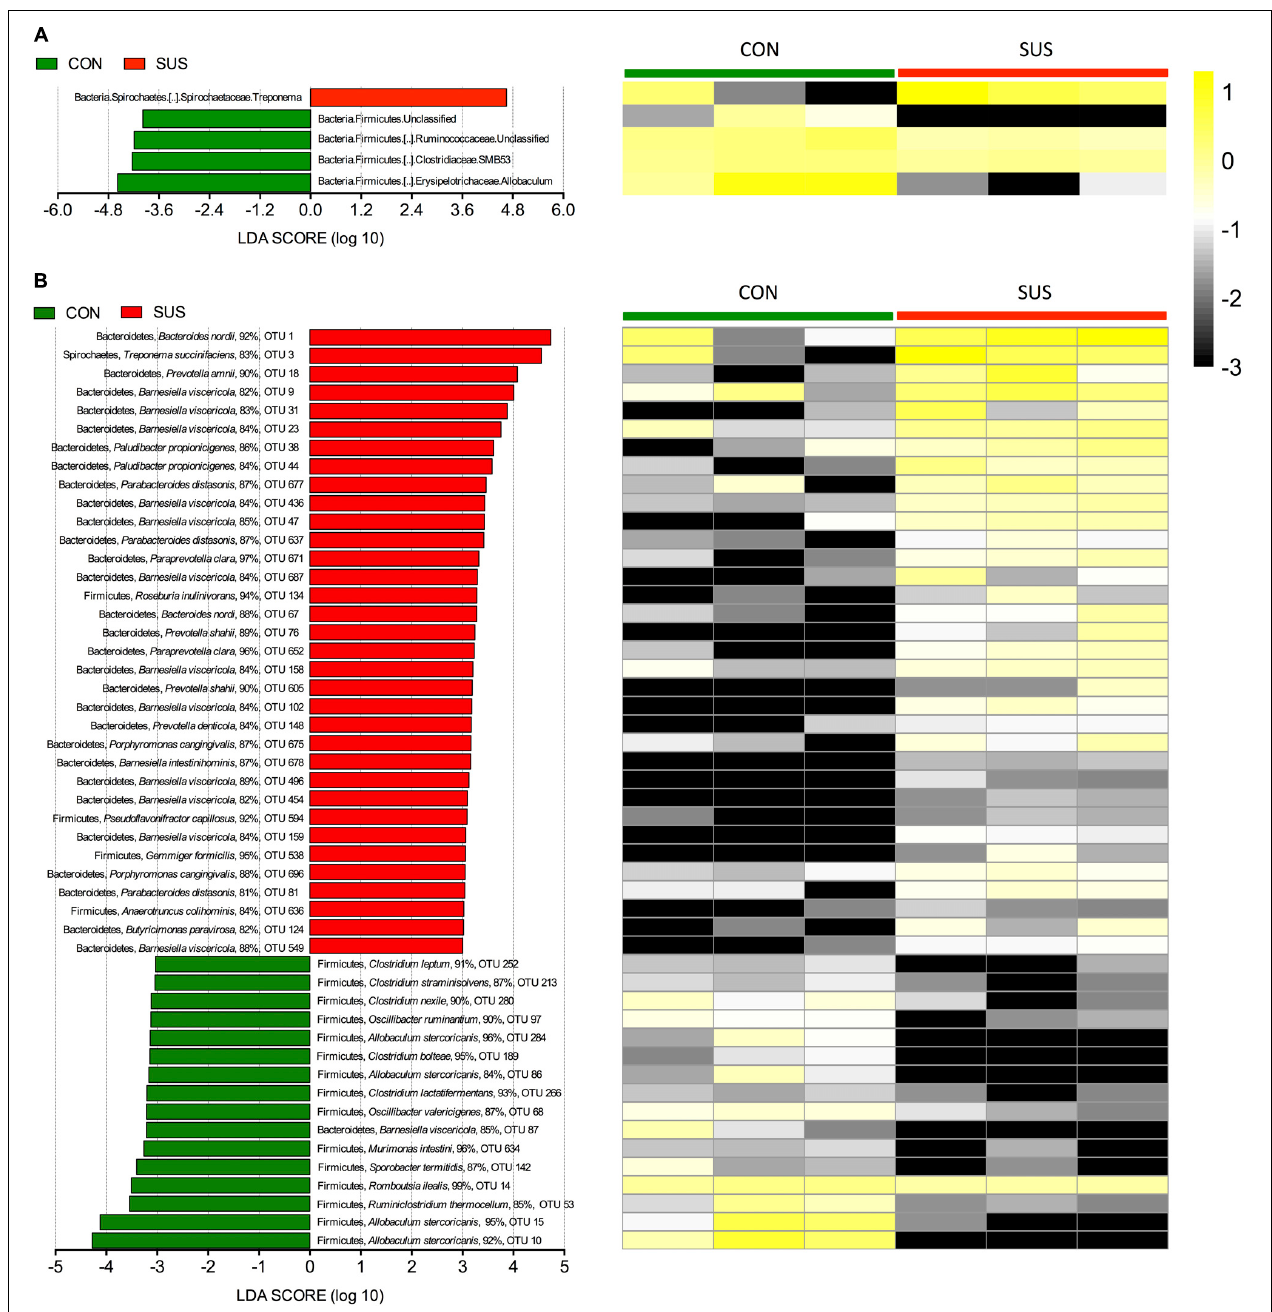
FIGURE 6 | Comparisons of caecal bacteria using LEfSe. The left histogram shows the LDA scores computed for features at the phylum (A) and OTU level (B) . The right heatmap shows the relative abundance of phylum and OTU (log 10 transformed). Each column represents one animal and each row represents the phylum and OTU corresponding to left one. CON, control group; SUS, simulated weightlessness